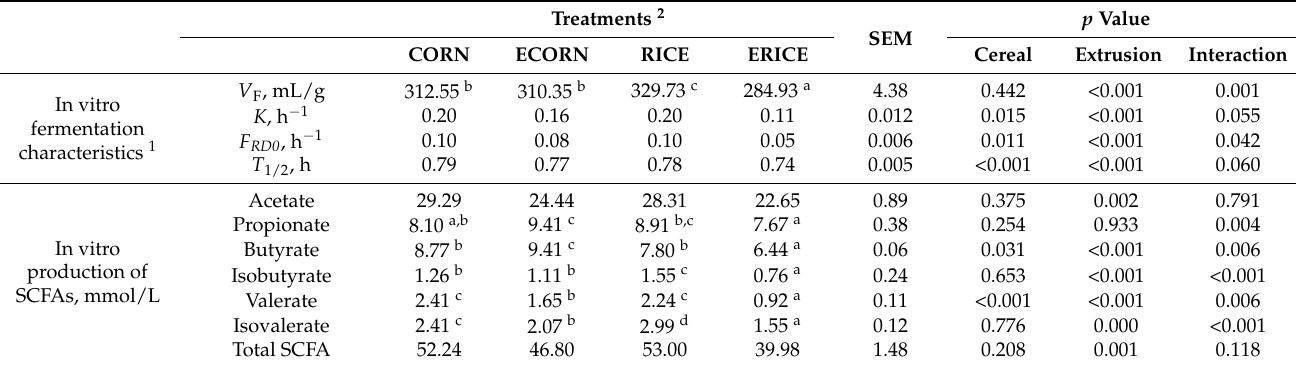
Figure 2. Effect of extrusion of corn and broken rice on gas production curve by fecal microbial fermentation. Treatments were corn as the main cereal type (CORN), or half of the corn replaced by extruded corn (ECORN), broken rice (RICE), and extruded broken rice (ERICE), respectively. Table 8. In vitro fermentation characteristics of the fecal